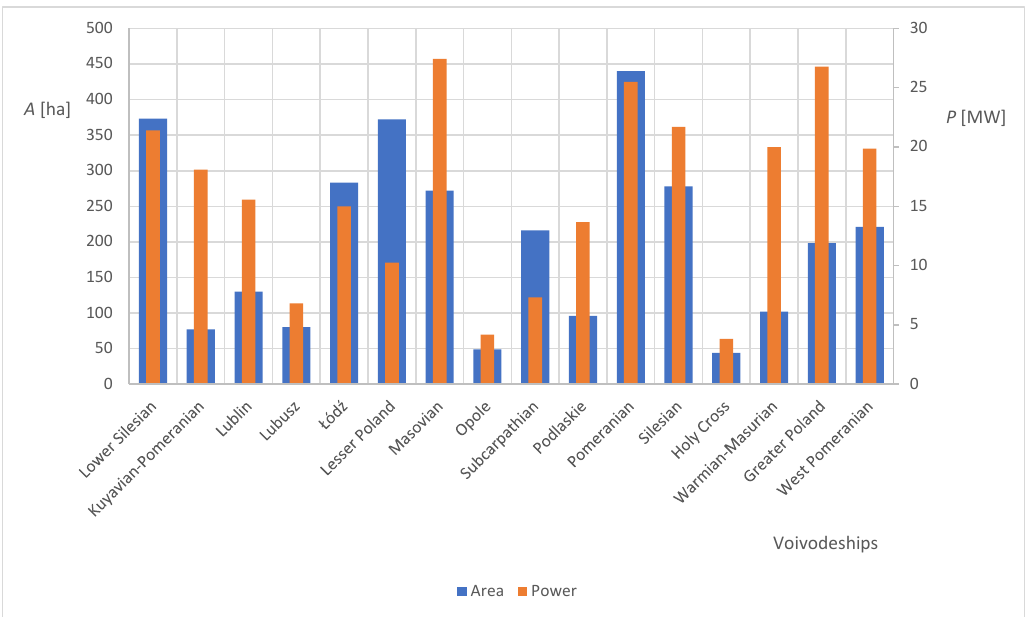
Figure 9. The relationship between the area of agricultural land potentially useful for the cultivation of energy crops (as of 2021) and the regional approach to the installation of power from biogas in Poland (own elaboration).